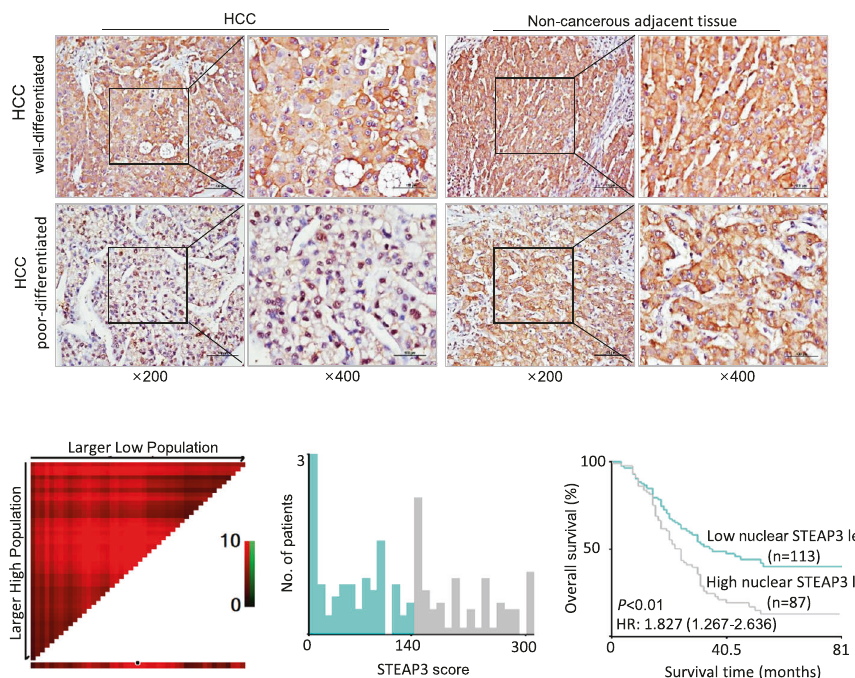
Fig. 1 Nuclear expression of STEAP3 is an independent prognostic factor for poor survival of HCC patients. A Expression levels of STEAP3 were examined by IHC in well- and poor-differentiated HCC tissues (left). Representative images show that STEAP3 was located in the cytoplasm in non-cancerous adjacent tissue (right) and well-differentiated HCC, but distributed in the nuclei in poor-differentiated HCC. Scale bar, 100 μ m. B X-tile plots were employed to determine the cut-point for the nuclear expression of STEAP3 in a large cohort of 200 HCCs. The cut-point was de fi ned as H -score > 140, and highlighted by the black circle in the horizontal axis (left) and demonstrated on a histogram of the cohort (middle). The χ 2 log-rank values were de fi ned by Kaplan – Meier method when using the cut-point to divide the cohort into low and high populations, and the p -value was determined (right) ( p <